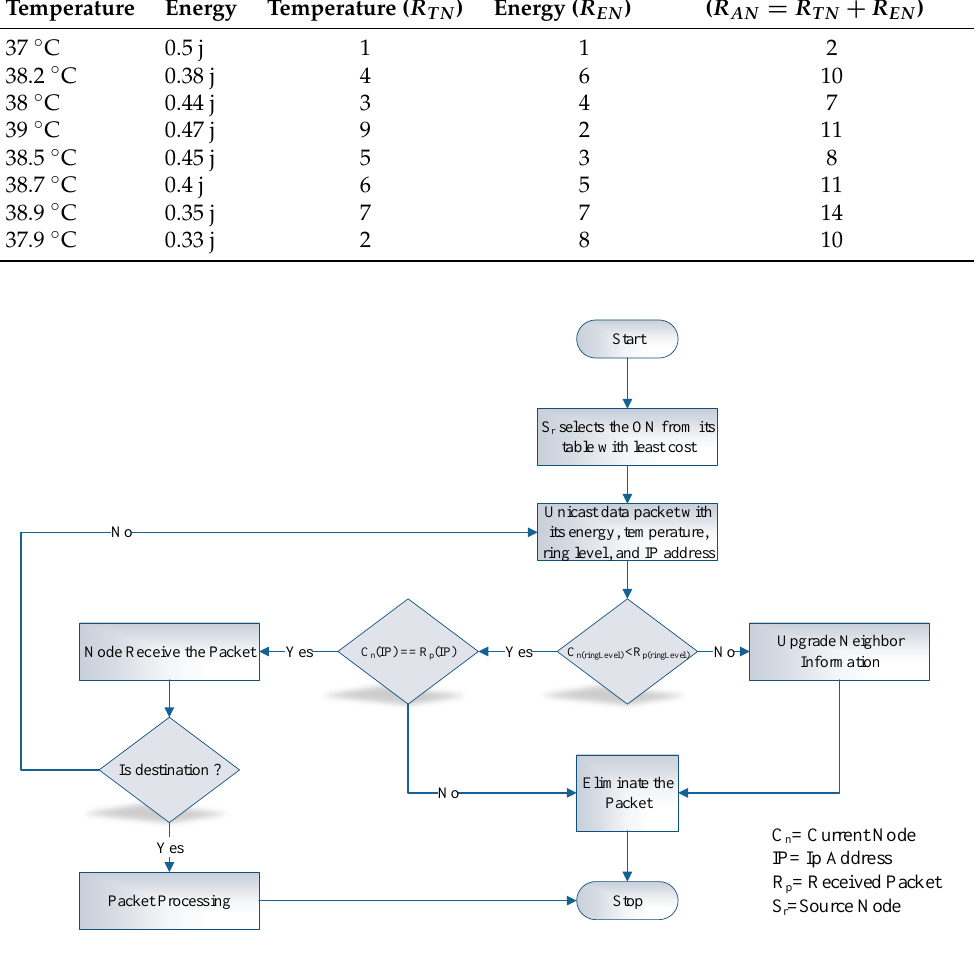
Figure 4. Initialization